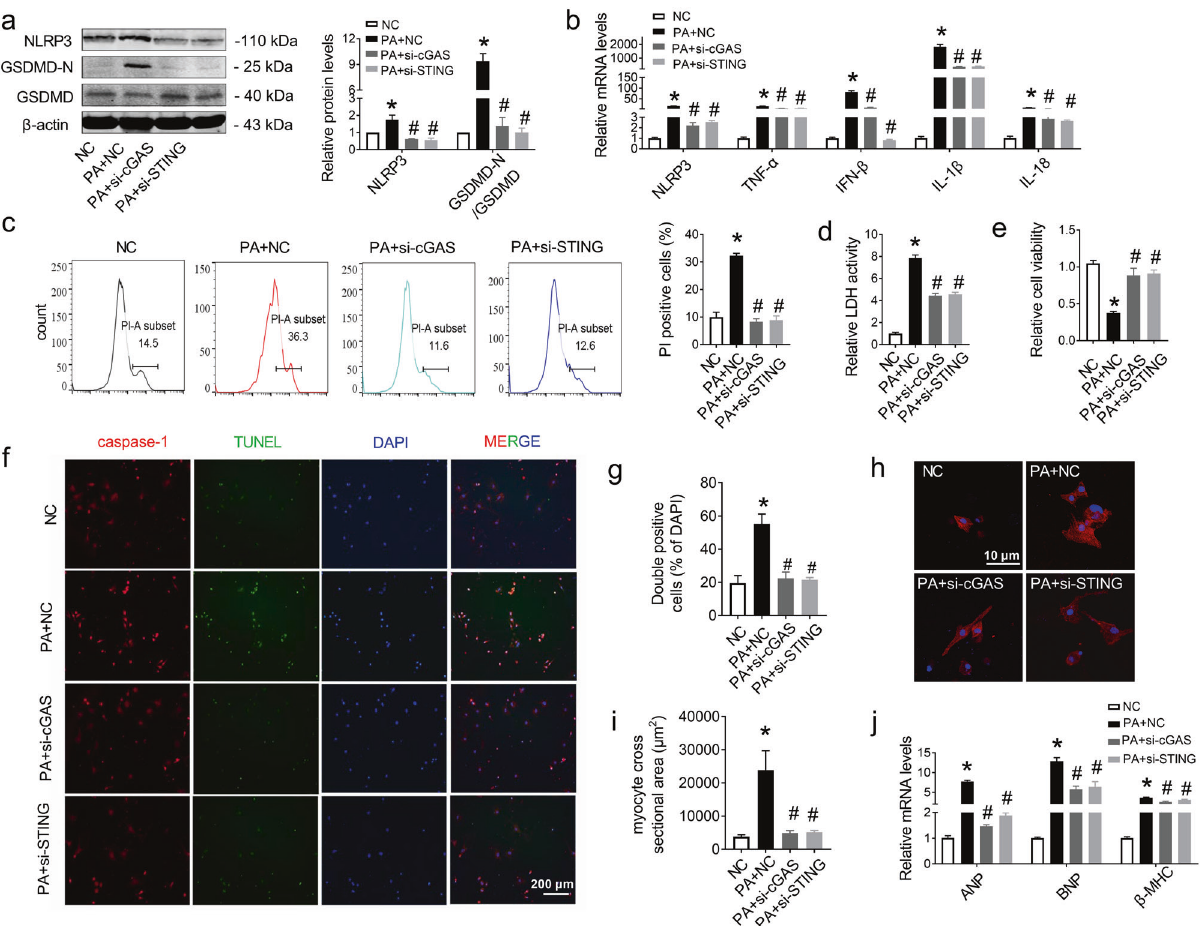
Fig. 5 Inhibited cGAS-STING pathway effectively reduced cardiomyocyte pyroptosis and hypertrophy induced by PA treatment. a Western blot analysis of NLRP3 and GSDMD-N/GSDMD after treatment with PA with or without siRNA of cGAS or siRNA of STING in H9C2 cells normalized to β -actin. n = 3 in each group. b Relative mRNA levels of NLRP3, TNF- α , IFN- β , IL-1 β , and IL-18 in H9C2 cells. n = 3 in each group. c Representative fl ow cytometry image and the corresponding quanti fi cation showing the number of PI + cells as the pyroptosis population. n = 4 in each group. d LDH release from each group of H9C2 cells. n = 8 in each group. e H9C2 cells were incubated with PA with or without siRNA of cGAS or siRNA of STING for 24 h and then evaluated by cell counting kit-8. n = 8 in each group. f , g Representative images and quantitative analysis of caspase-1 (red) and TUNEL (green) double-positive cells in PA-induced NMCMs. n = 5 in each group. h , i Quantitative analysis of the myocyte cross-sectional area by α -actinin staining in NMCMs. n = 6 in each group. j mRNA levels of ANP, BNP, and β -MHC in H9C2 cells. n = 3 in each group. Values are the mean ± SEM. * P < 0.05 vs. NC, # P < 0.05 vs. PA-treated cells. NC negative control, PA palmitic acid, si-cGAS small interfering RNA of cGAS, si-STING small interfering RNA of